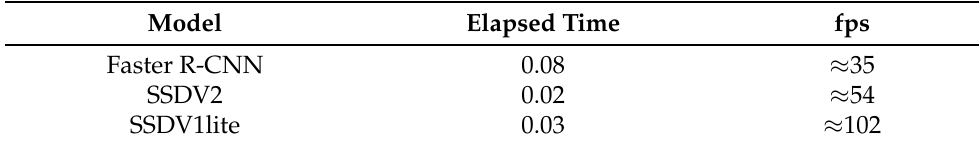
Table 2. Elapsed time and fps tabulated.